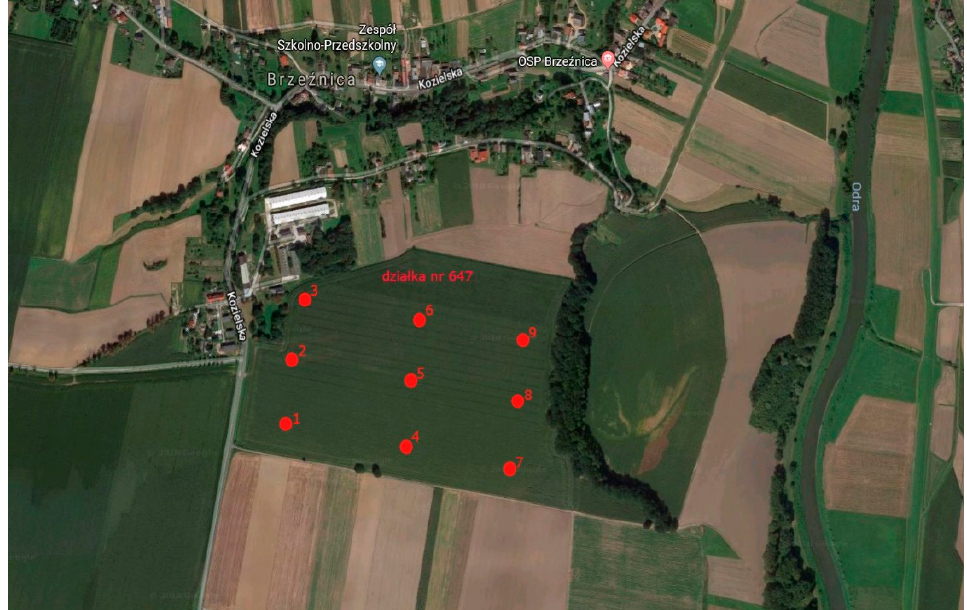
Figure 2. Location of experiment points (source: www.googlemap.pl (accessed on 20 November 2022)).